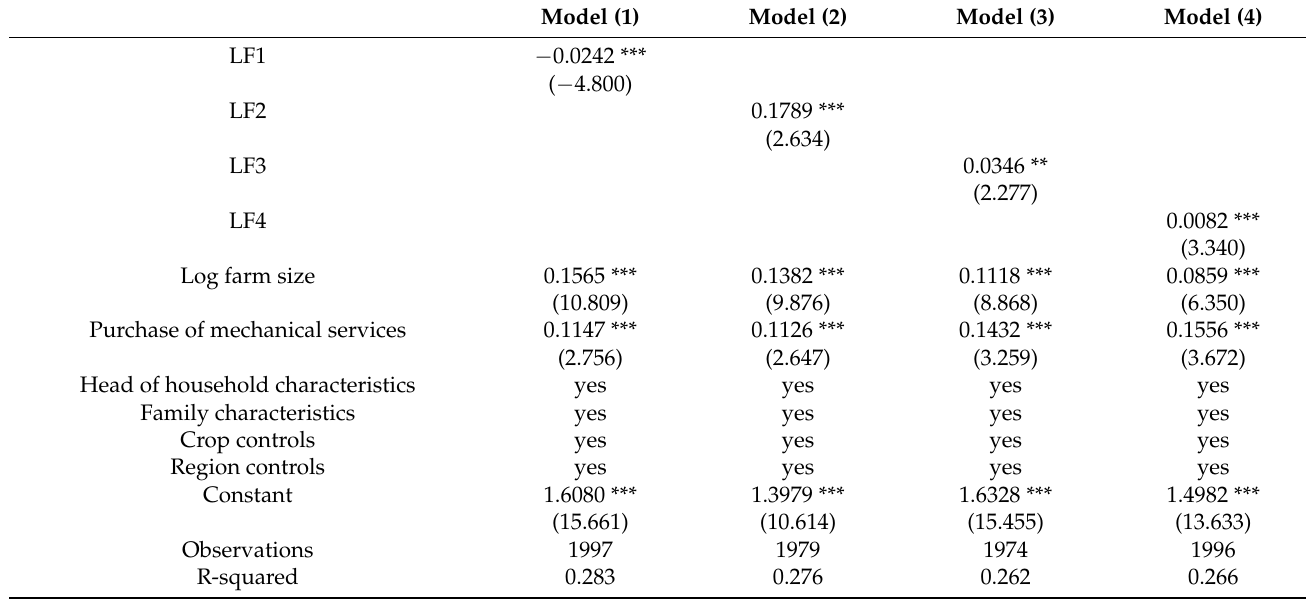
Table 11. Analysis of the effect of LF on tilling efficiency (controlling for whether to purchase mechanical service